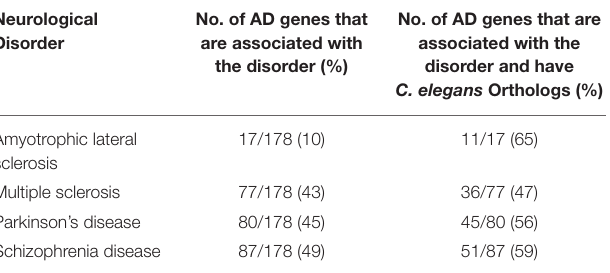
TABLE 3 | Distribution of the 178 human AD genes that are associated with other disorders. Neurological